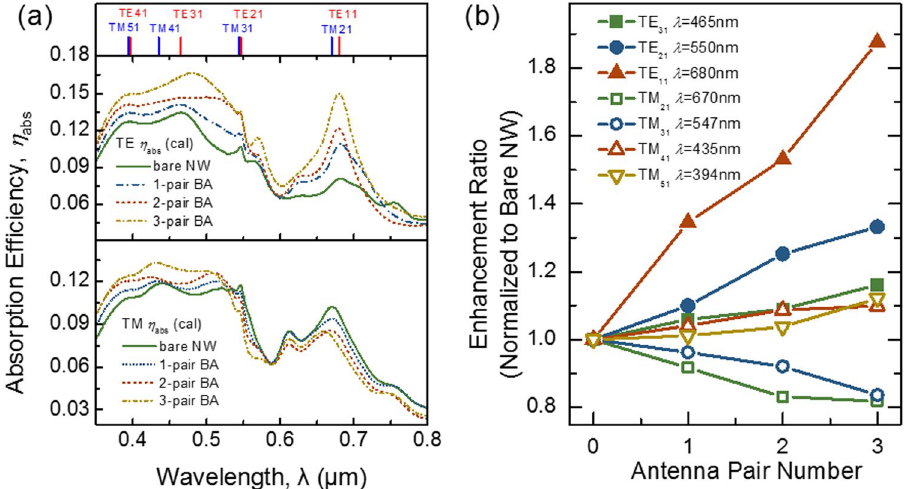
Figure 4. Absorption efficiency with the optimized parameters of the designed device. ( a ) Calculated absorption efficiency for the TE modes and TM modes. The locations of resonance modes are indicated at the top of the figure. ( b ) Absorption enhancement for TE and TM modes with respect to bare nanowire for different number of antenna